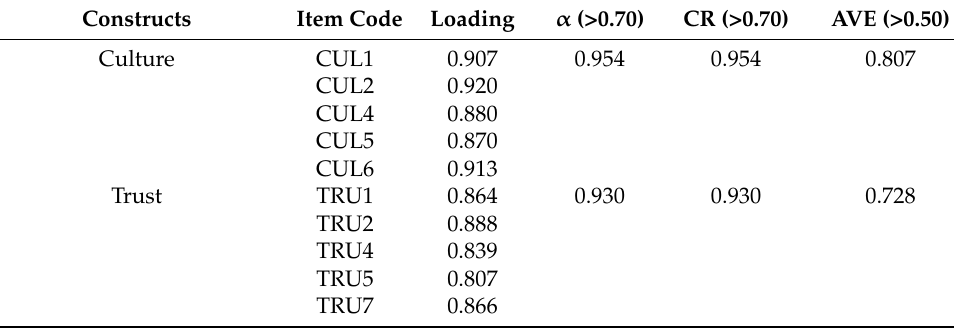
Table 3. Overall convergent validity of the proposed measurement model.